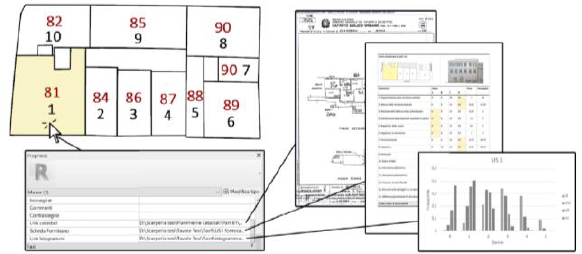
Figure 8. Digital information provided into the H-BIM at AL (Bonaguidi,